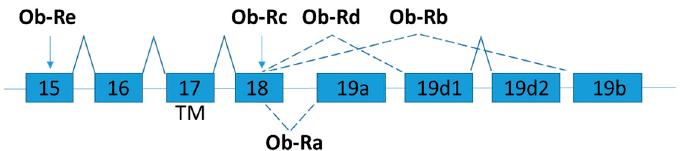
Figure 2. Schematic figure representing leptin receptor (Ob-R) splice variants. Exons are represented by boxes. Alternative splicing sites are depicted by connections with dashed lines. Exon 17 encodes the trans-membrane domain (TM) [59].